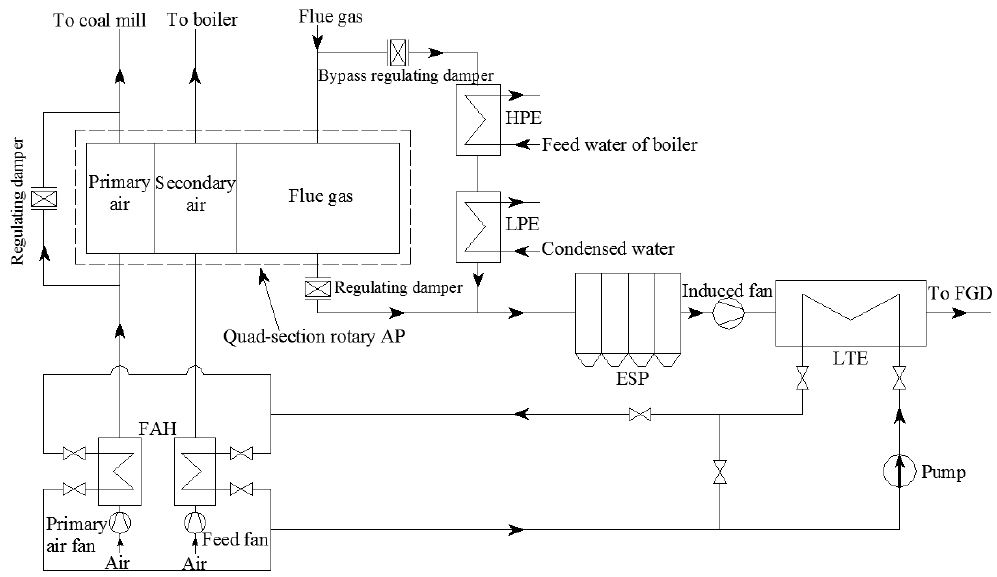
Figure 1. Schematic of coupled high–low energy flue gas waste heat use system. AP: Air Preheater; FAH: Front located Air Heater; LTE: Low Temperature Economizer; LPE: Low Pressure Economizer; HPE: High Pressure Economizer; FGD: Flue Gas Desulfurization; ESP: Electrostatic Precipitator.